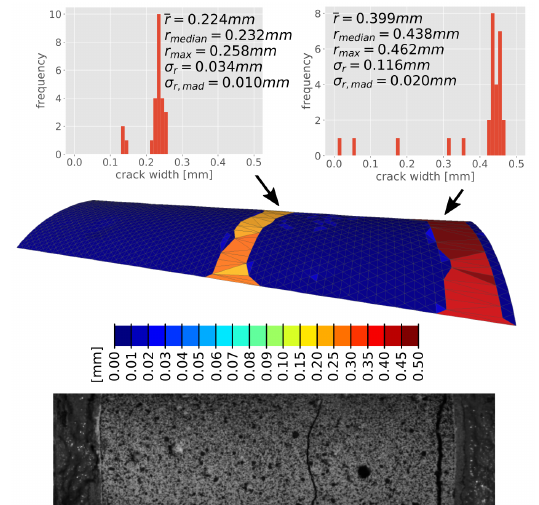
Figure 13. Color-coded visualization of || (cid:126)t rel, 2 D || for epoch 29 at 0.28 ms. For the two cracks, histograms of the crack widths are depicted. In addition, the original image of one camera is shown.